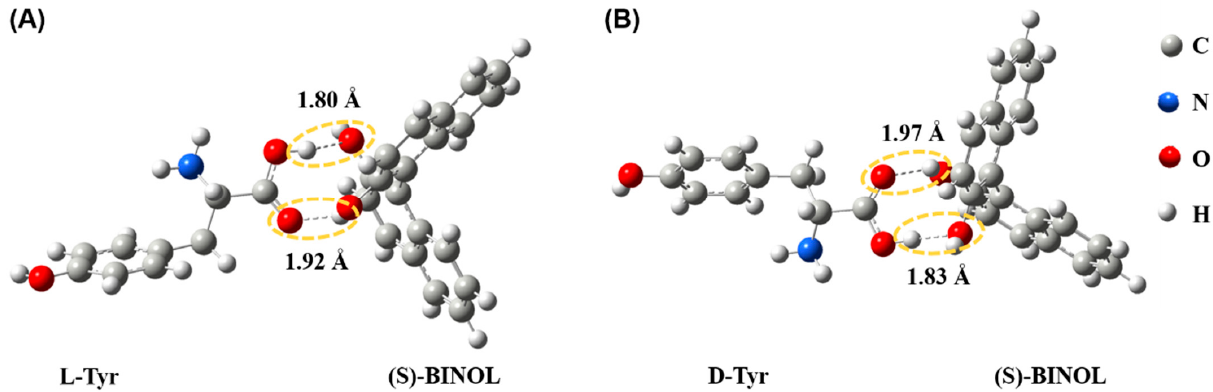
12 of 16 Figure 9. ( A ) Nyquist plots of TCPP-Zn-(S)-BINOL/GCE in 0.1 M PBS containing 5.0 mM [Fe(CN) 6 ] 4 − /3 − before (a) and after its incubation with 2 mM D-Tyr (b) and L-Tyr (c). ( B ) Cyclic volt- ammograms of L-Tyr/GCE in 0.1M HEPES containing 0.3 M KCl in the absence (a) and presence (b) of 12 mM H 2 O 2 . In addition, L-Tyr was also found to have a good catalytic reduction effect on hydro- gen peroxide. It can be seen from Figure 9B that in the presence of H 2 O 2 , the reduction current intensity of L-Tyr is significantly greater than that in the absence of H 2 O 2 , indicat- ing that L-Tyr can electrocatalytically reduce H 2 O 2 to generate hydroxyl radicals, which is the key substance in ECL luminescence. In order to further study the mechanism of chiral recognition, DFT was used to ana- lyze the ground-state structures of different systems. For simplicity, (S)-BINOL was used in the MD simulation instead of TCPP-Zn-(S)-BINOL, because (S)-BINOL is the only chiral source in the module. Although (S)-BINOL can form two hydrogen bonds with L-Tyr